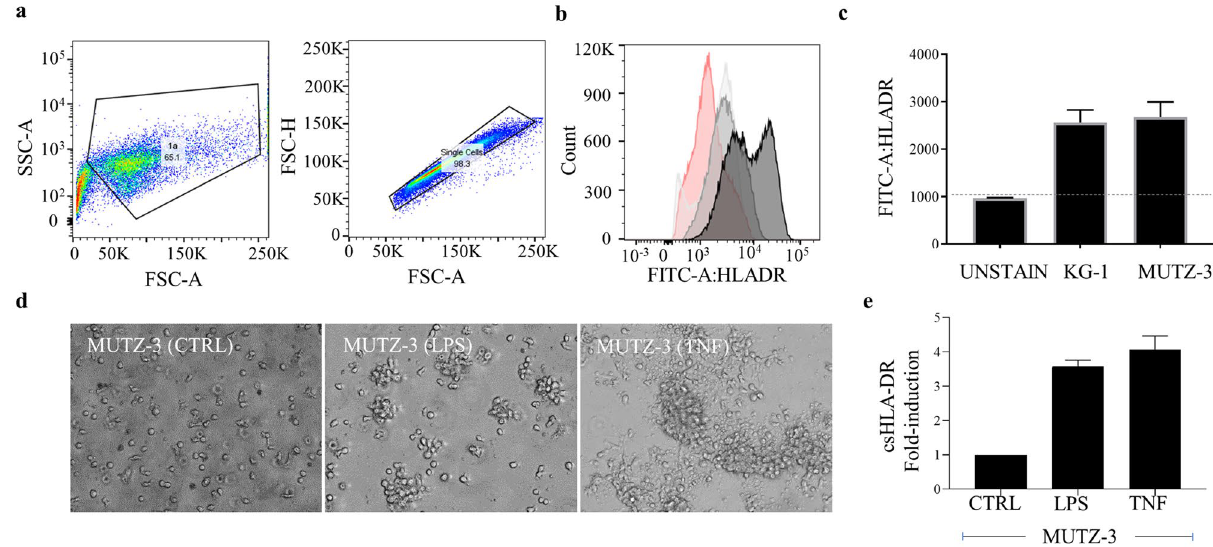
Figure 1. Proinflammatory stimulants LPS and TNF induce HLA-DR at the cell surface (csHLA-DR) in dendritic-like cell model. ( a ) KG-1 dendritic-like cell populations analyzed by FACS gated by SSC-A and FSC-A as well as FSC-H and FSC-A, representative plots. ( b ) csHLA-DR in KG-1 non-stained control (red), KG-1 (light gray), MUTZ-3 (dark gray) and stimulated MUTZ-33 (black). ( c ) Median fluorescence intensity (MFI) FITC- A:HLADR signal of KG-1 and MUTZ-3 cell lines normalized to unstained control (n = 3), each bar represents the mean and the standard deviation (SD). ( d ) Morphology of unstimulated and stimulated MUTZ-3 cells by light microcopy (40x). Left to right, unstimulated MUTZ-33 cells (control, CTRL), MUTZ-3 treated with LPS or TNF at 1 µg/mL and 100 ng/mL, respectively. ( e ) csHLA-DR fold induction measured by flow cytometry in stimulation conditions normalized to unstimulated control (n = 3), each bar represents the mean and the